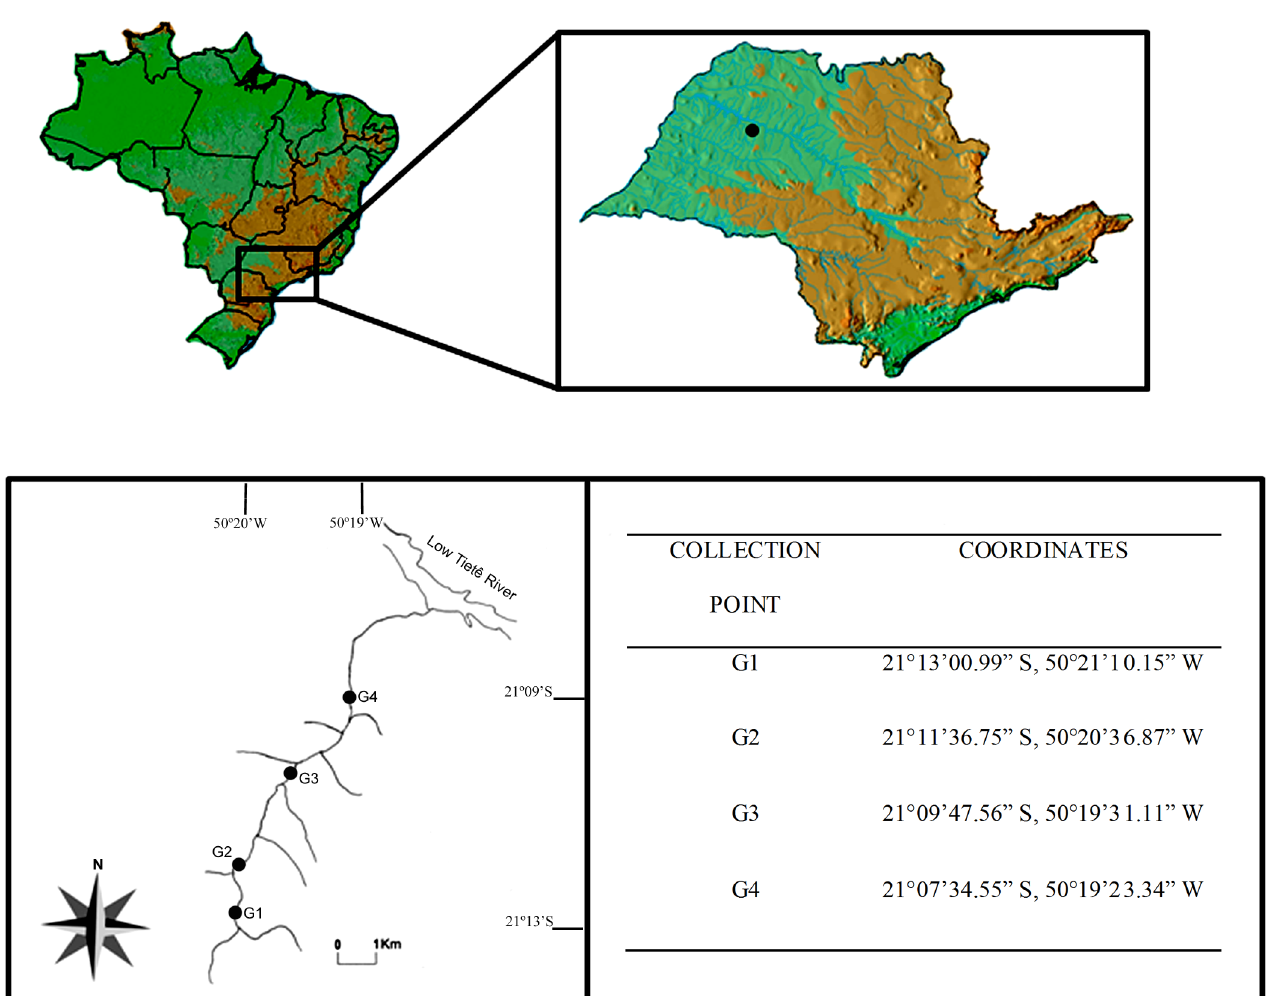
Figure 1. Hydrographic map of the Riacho Goulart, black circles correspond to sampled sites and geographic